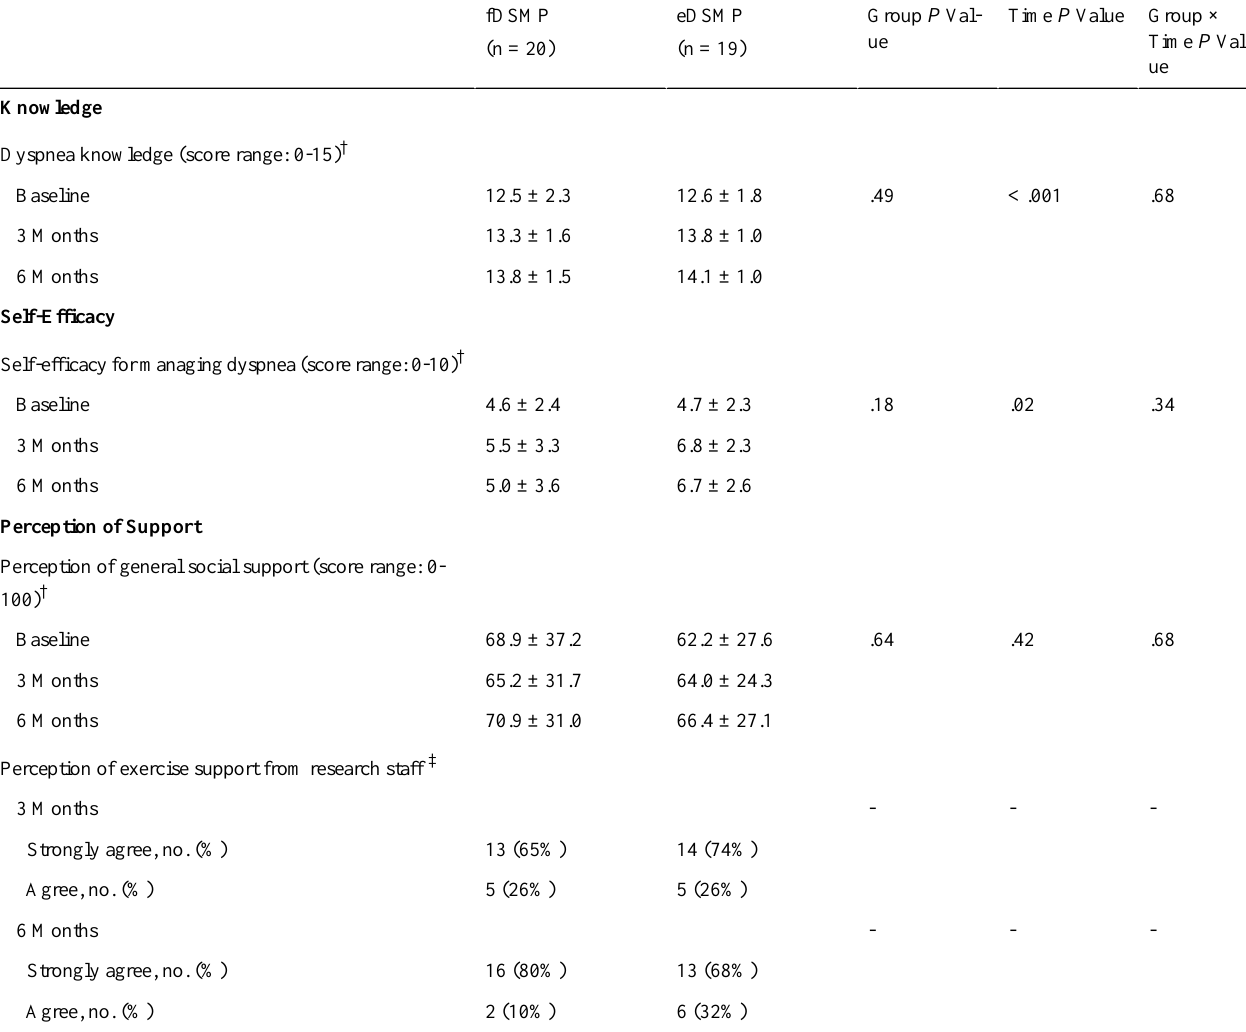
Table 4. Comparison of mediators of treatment effects: knowledge, self-efficacy, and perception of